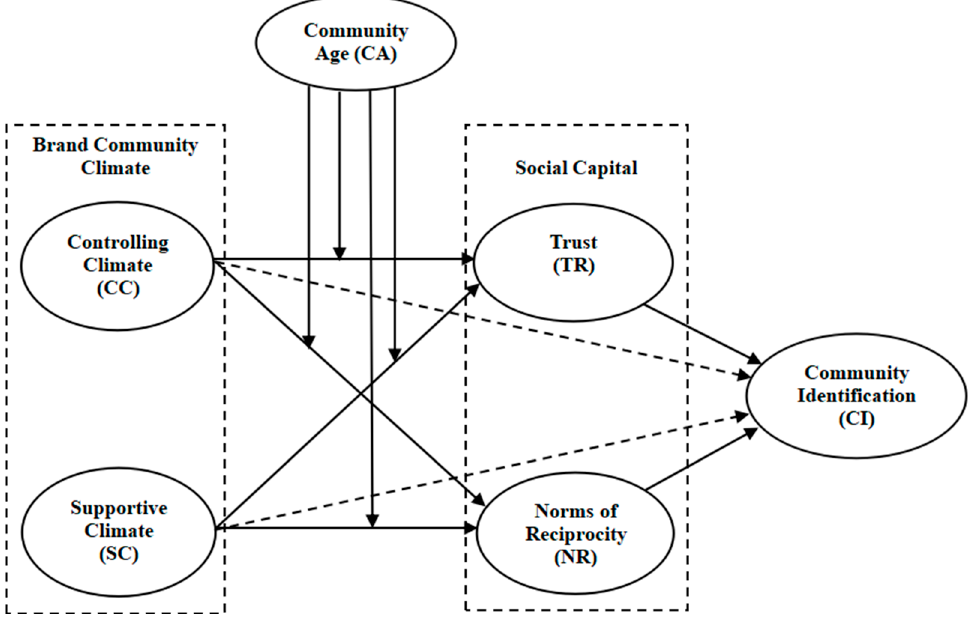
Figure 1. C onceptual framework. Figure 1. Conceptual